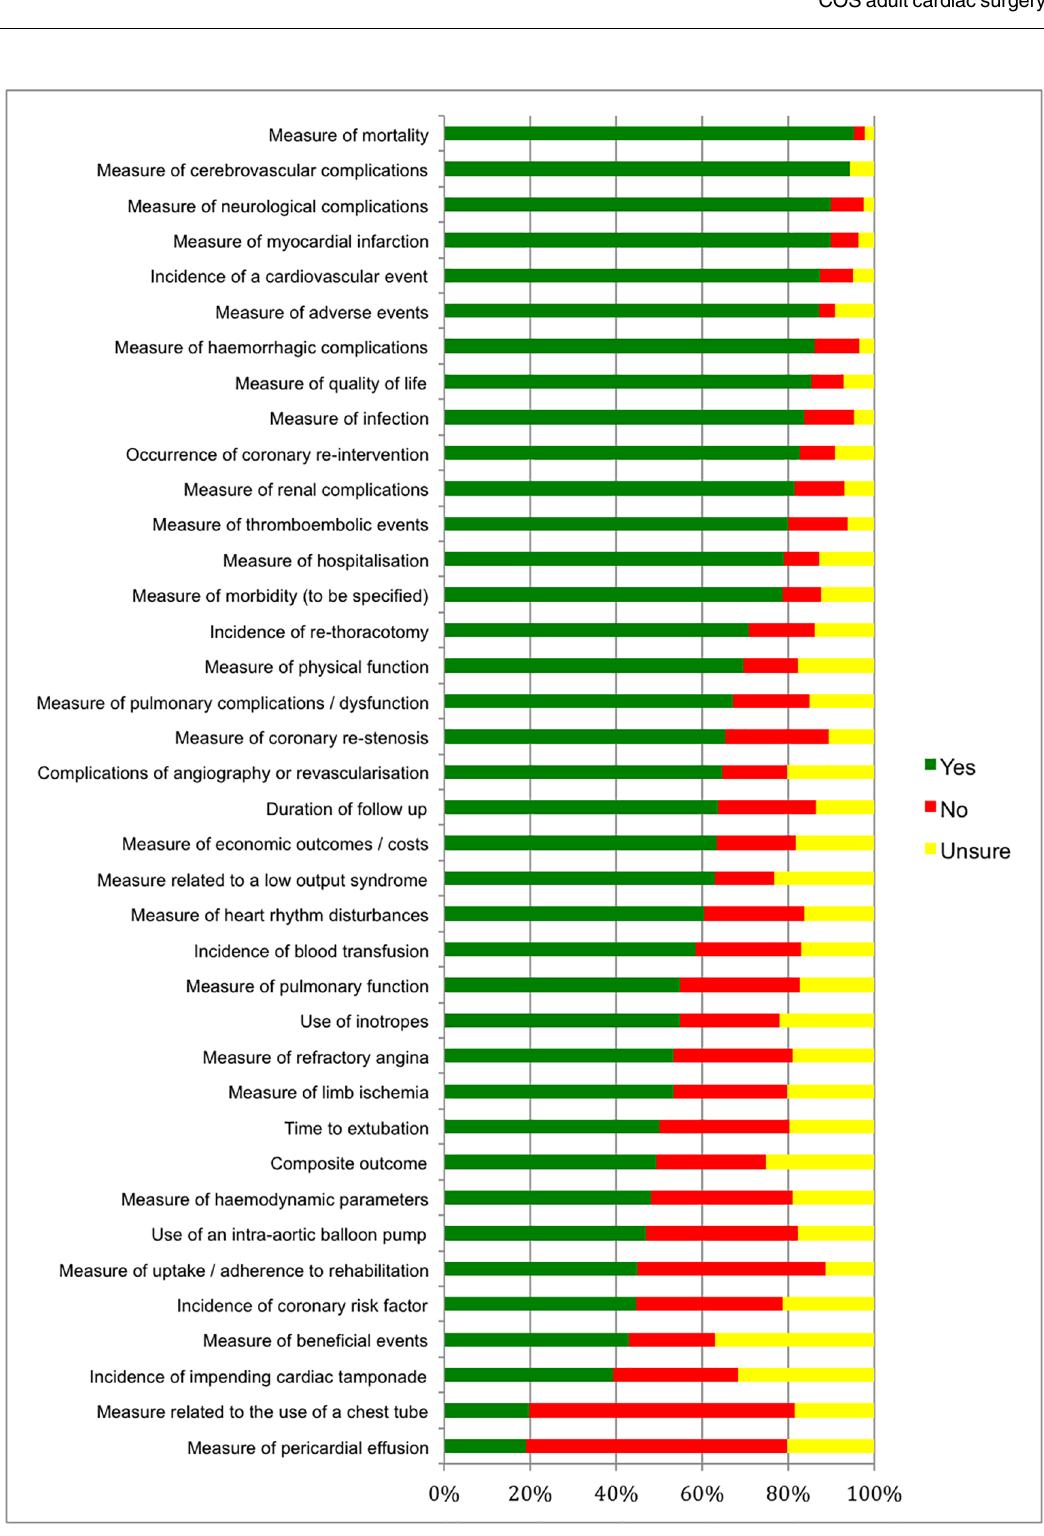
PLOS ONE | https://doi.org/10.1371/journal.pone.0186772 November2,